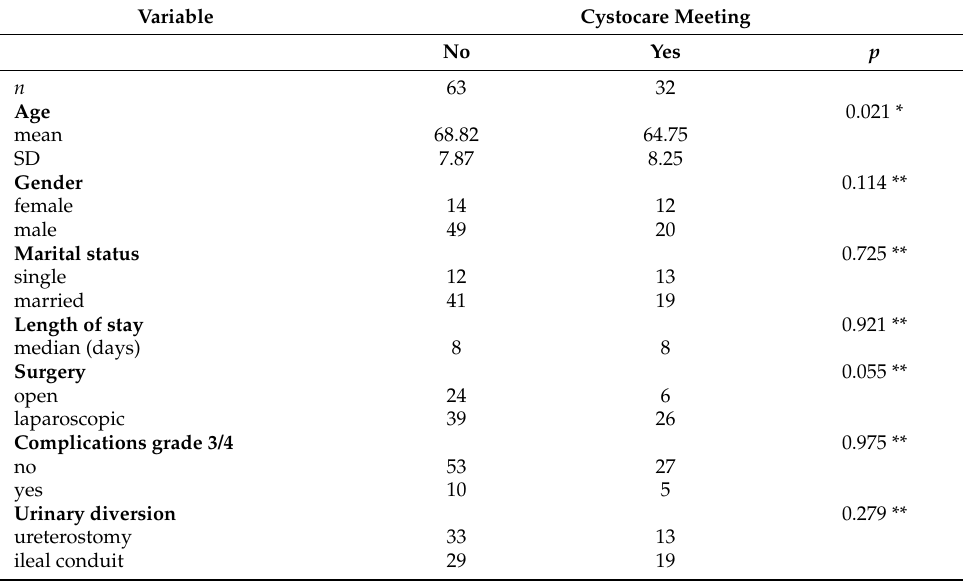
Table 1. Characteristics of the study